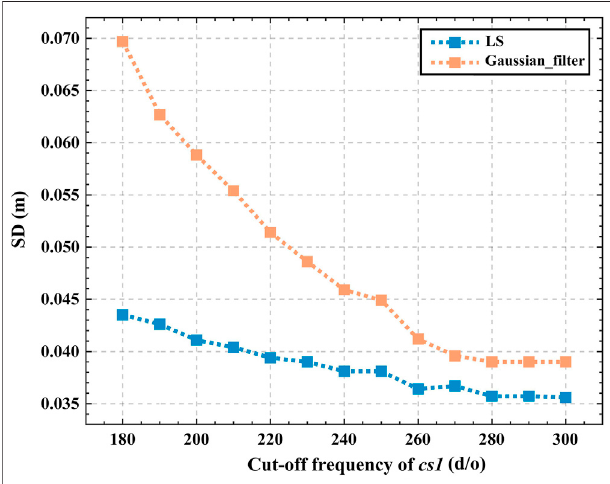
FIGURE 6 | The SD of mis fi ts under different cut-off frequency of cs 1. (The LS represents estimated MDT solution based on the DIR6 GGM; The Gaussian_ fi lter represents the Gaussian fi ltered solution based on DIR6